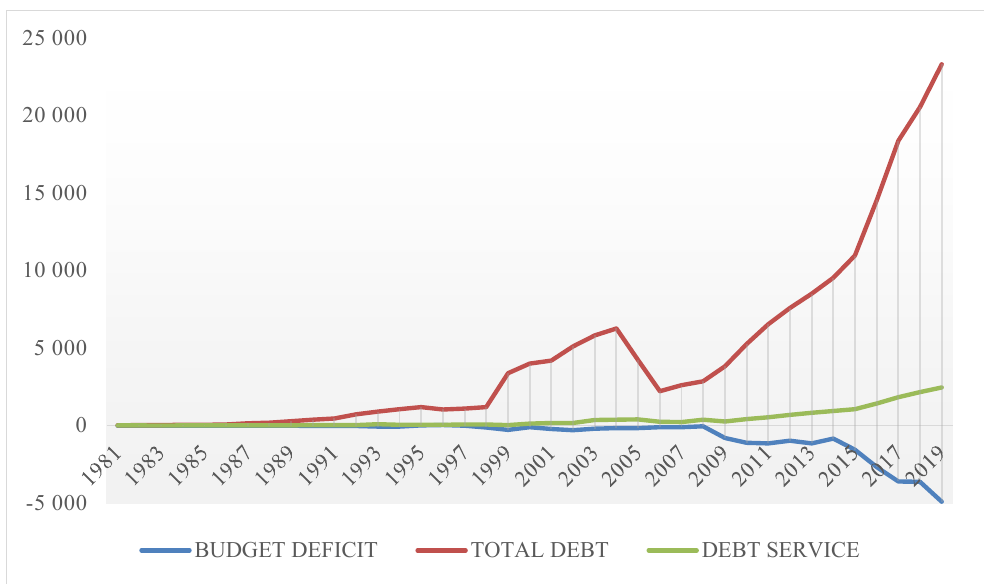
Fig. 3. Nigeria’s debt profile ( Central Bank of Nigeria Statistical Bulletin,